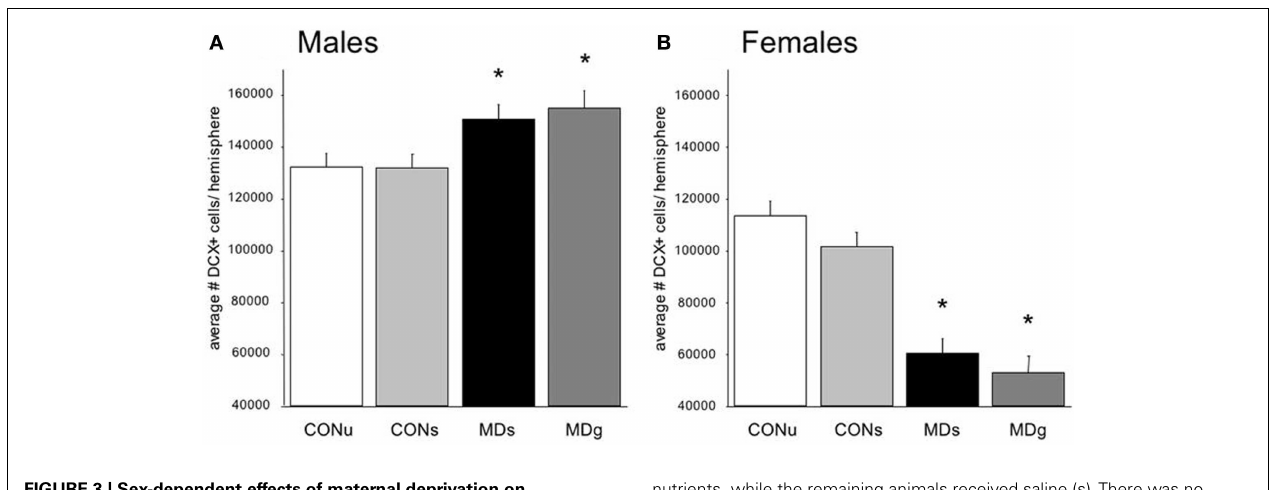
FIGURE 3 | Sex-dependent effects of maternal deprivation on neurogenesis . (A) The number of Doublecortin (DCX)-positive neurons in the entire dentate gyrus from 21-days-old male rats, which underwent MD for 24h at postnatal day (PND) 3, was significantly (* p < 0.05; n = 7 animals) enhanced compared to the non-deprived controls (CON). Half of the animals received glucose (g) on day 3, to compensate for the loss in